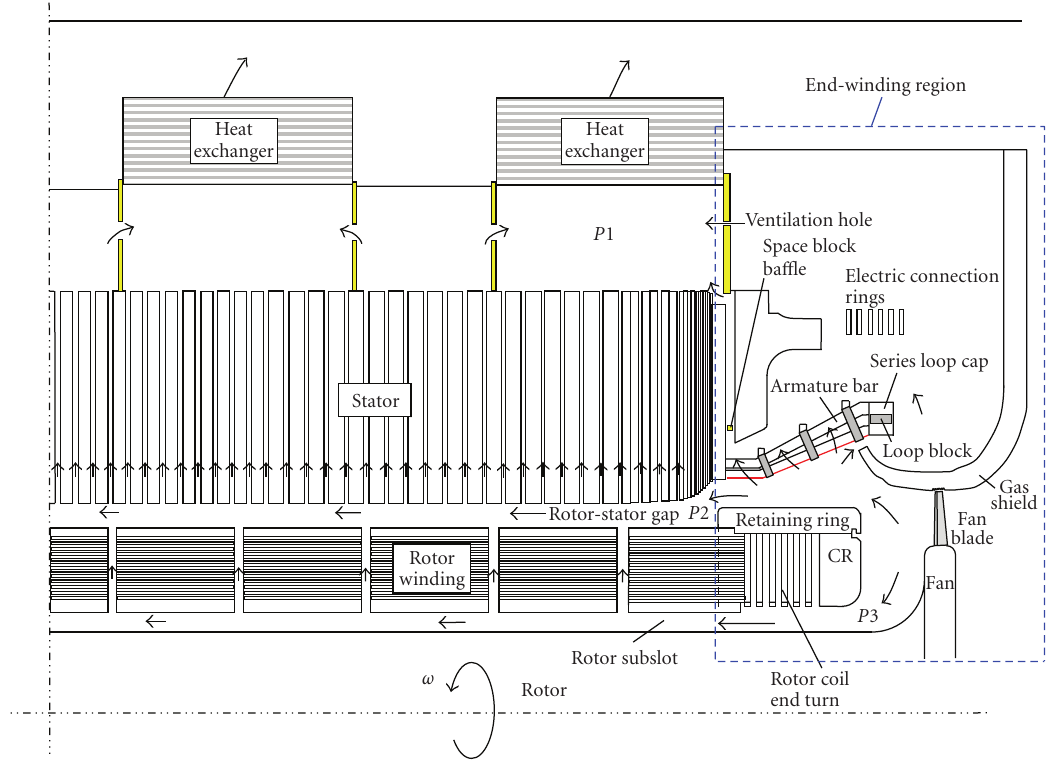
Figure 1: Schematic diagram of the generator cooling system and end-winding